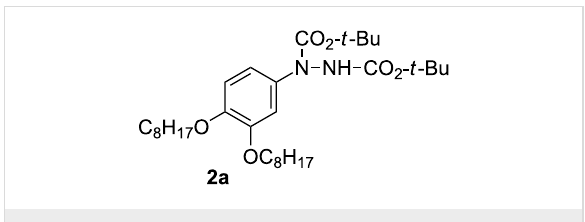
Figure 3: Structure of hydrazide 2a .